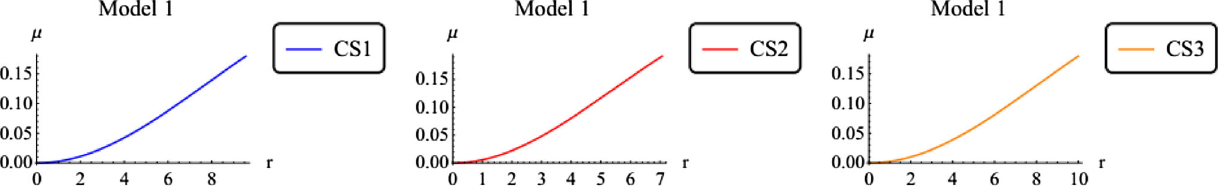
Fig. 16 Variations of the compactness for different charged compact